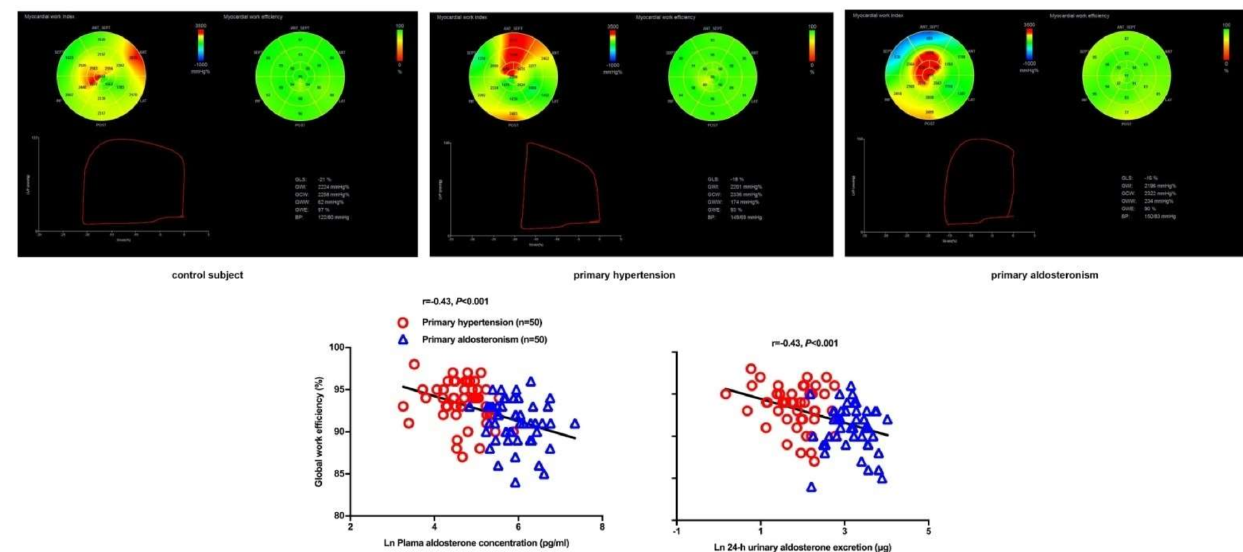
Figure 3. Myocardial work analysis in a control subject ( upper left ), primary hypertensive patient ( upper middle ) and primary aldosteronism patient ( upper right ) and the correlation analysis between global work efficiency with plasma aldosterone concentration ( lower left ) and urinary aldosterone excretion ( lower right ). The correlation coefficients and corresponding p values are given for all subjects. Reproduced from Chen YL, et al. [79].